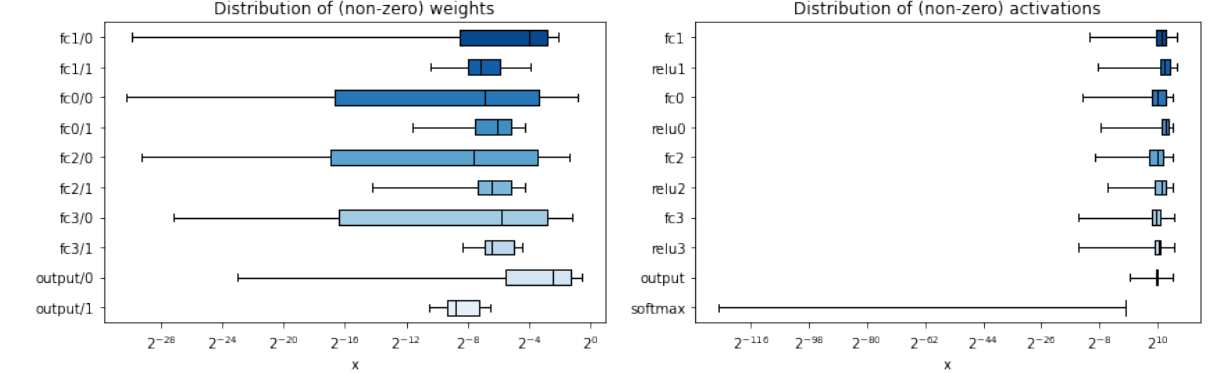
Figure 9. Distribution of weights and activations for each layer in the base